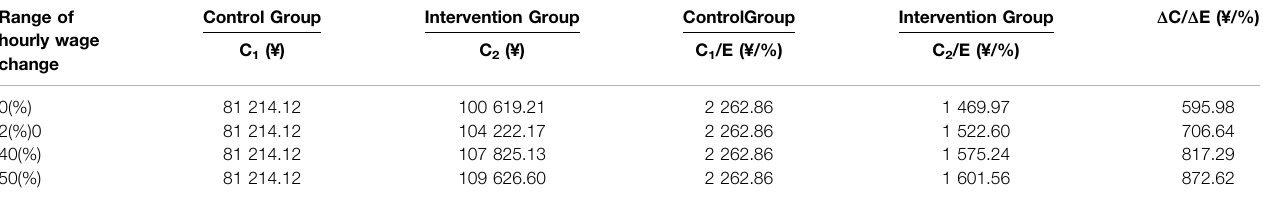
TABLE 6 | Results of sensitivity analysis for hourly salary changes among clinical pharmacists. Range of hourly